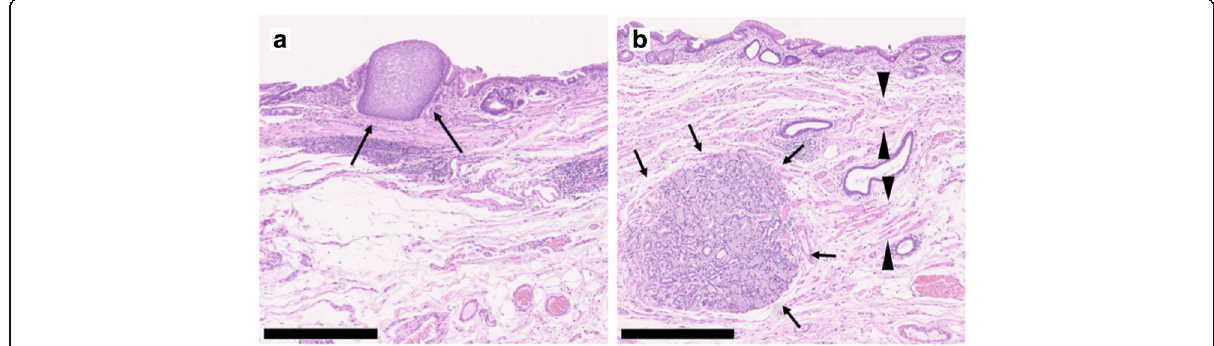
Fig. 4 Histological findings of Barrett ’ s esophagus. BE was recognized histologically. Some islands of squamous epithelium ( a , arrow), esophageal glands beneath the columnar epithelium ( b , arrow), and double-layered muscularis mucosae ( b , arrow head) were observed. All scale bars — 500 μ m